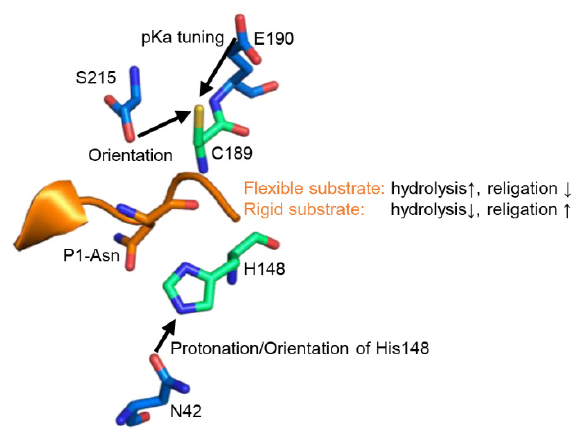
Figure 6. Legumain activities are regulated by extended active site residues and substrate confor- mation. Zoom-in view on the active site of legumain as seen in the crystal structure of legumain in complex with cystatin M/E (pdb 4n6o). The catalytic Cys189 and His148 residues are shown in green sticks, regulatory residues on legumain in blue sticks. The position of the substrate is indicated by the reactive center loop of cystatin M/E (orange).